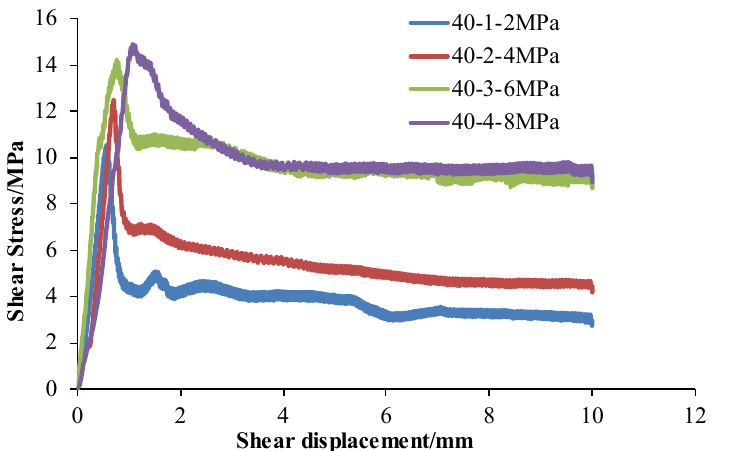
Figure 8. Shear stress–displacement curves under different normal stresses at a 0.6 mm/min shear rate with a 40° undulating angle. Table 2. Shear strength of structural planes with different undulating angles under different normal stresses at a 0.6 mm/min shear rate (MPa).